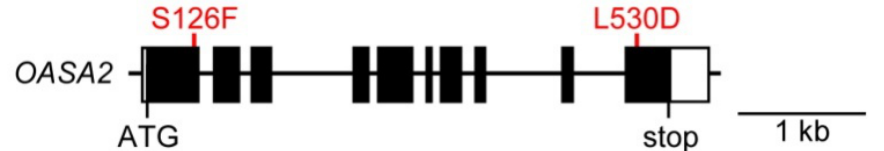
Figure 1. Structure of the OASA2 gene. The mutations S126F (S [TCC] to F [TTC] at amino acid 126) and L530D (L [CTT] to D [GAC] at amino acid 530) were introduced successfully into the endogenous OASA2 gene via gene targeting (GT) [4]. Molecular analysis revealed that true GT, in which the wild-type OASA2 gene was mutated as expected, had occurred successfully